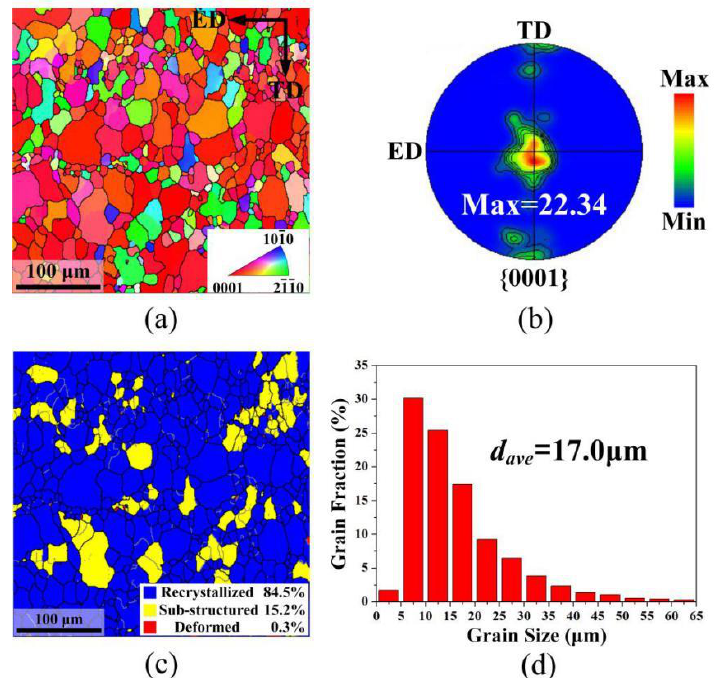
Figure 3. Microstructure and texture of as-extruded AZ80 alloy: ( a ) electron backscatter diffraction (EBSD)-inverse pole figure (IPF) map; ( b ) {0001} pole figure; ( c ) grain type distribution maps (blue, recrystallized; yellow, substructured; red, deformed); and ( d ) grain size distribution.